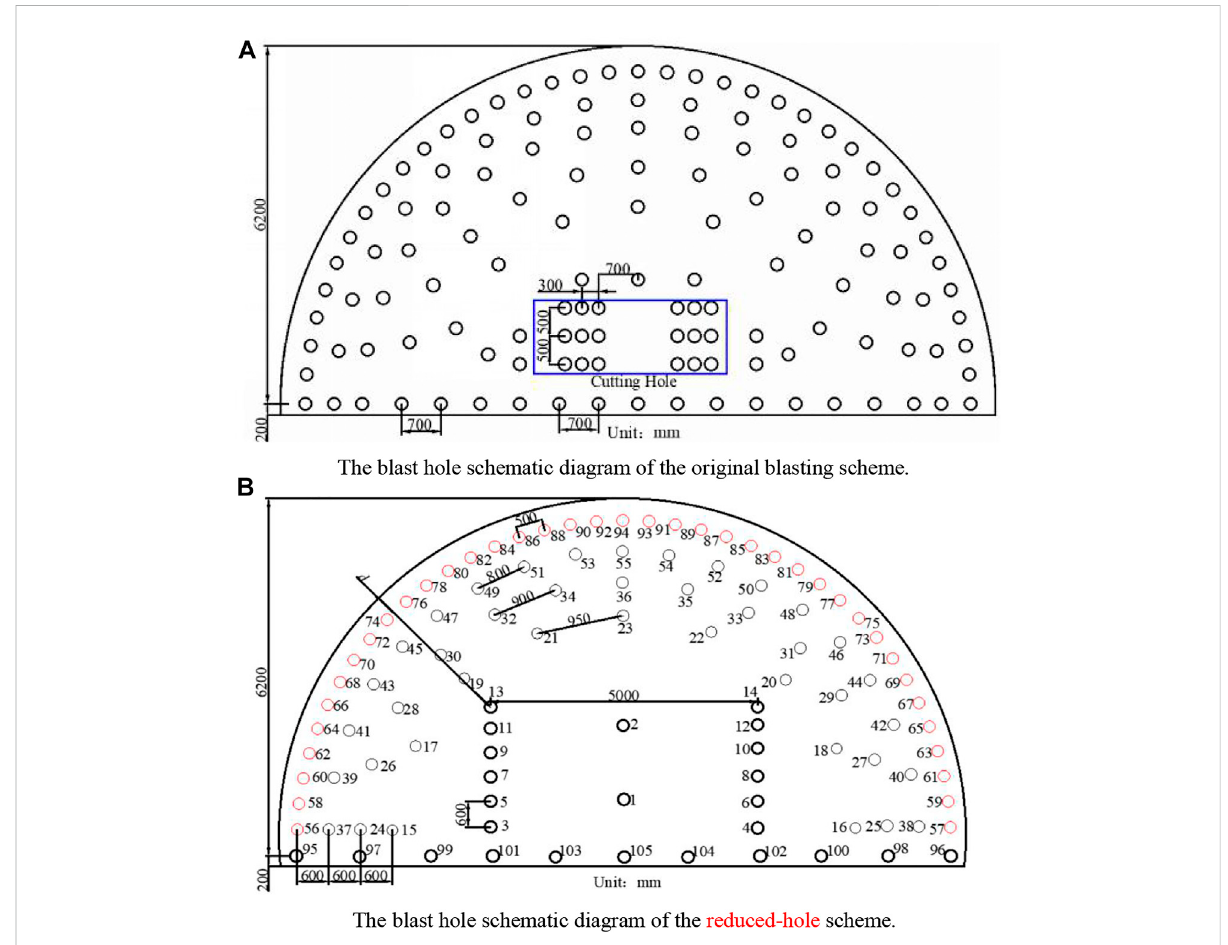
FIGURE 5 Schematicdiagramoftheblastholelayout. (A) Blastholeschematicdiagramoftheoriginalblastingscheme. (B) Blastholeschematicdiagramof the reduced-hole